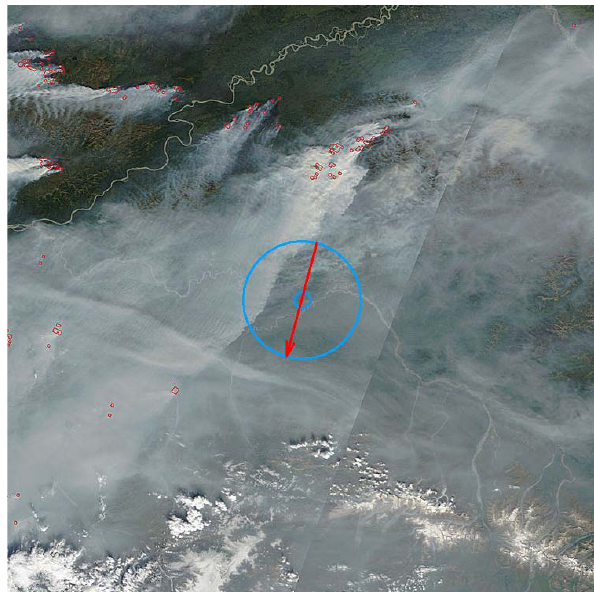
Fig. 3. True-color picture of Alaska forest fires acquired by the Terra MODIS sensor on 15 August 2005 at 22:15UTC over Bo- nanza Creek AERONET station. The smaller circle in the center of the picture shows the location of the station, while the larger circle highlights the MAPSS sampling area over this station. The red arrow represents the azimuth of the slope of the fitted plane ( slaz =194.86). In this particular case, the azimuth is co-directional with the flow of the wind and indicates the direction of the smooth ( slop =22.38) gradient of aerosol loading in the area, produced by the wind. Please note that the thick smoke plume in the left part of the sampling area has no AOD retrieval. MAPSS parameters for this case: slaz : 194.86, slop : 22.38, mcoc : 0.53, mean : 0.8, cval : 0.74, sdev : 0.1, ndat : 14, nval : 11.